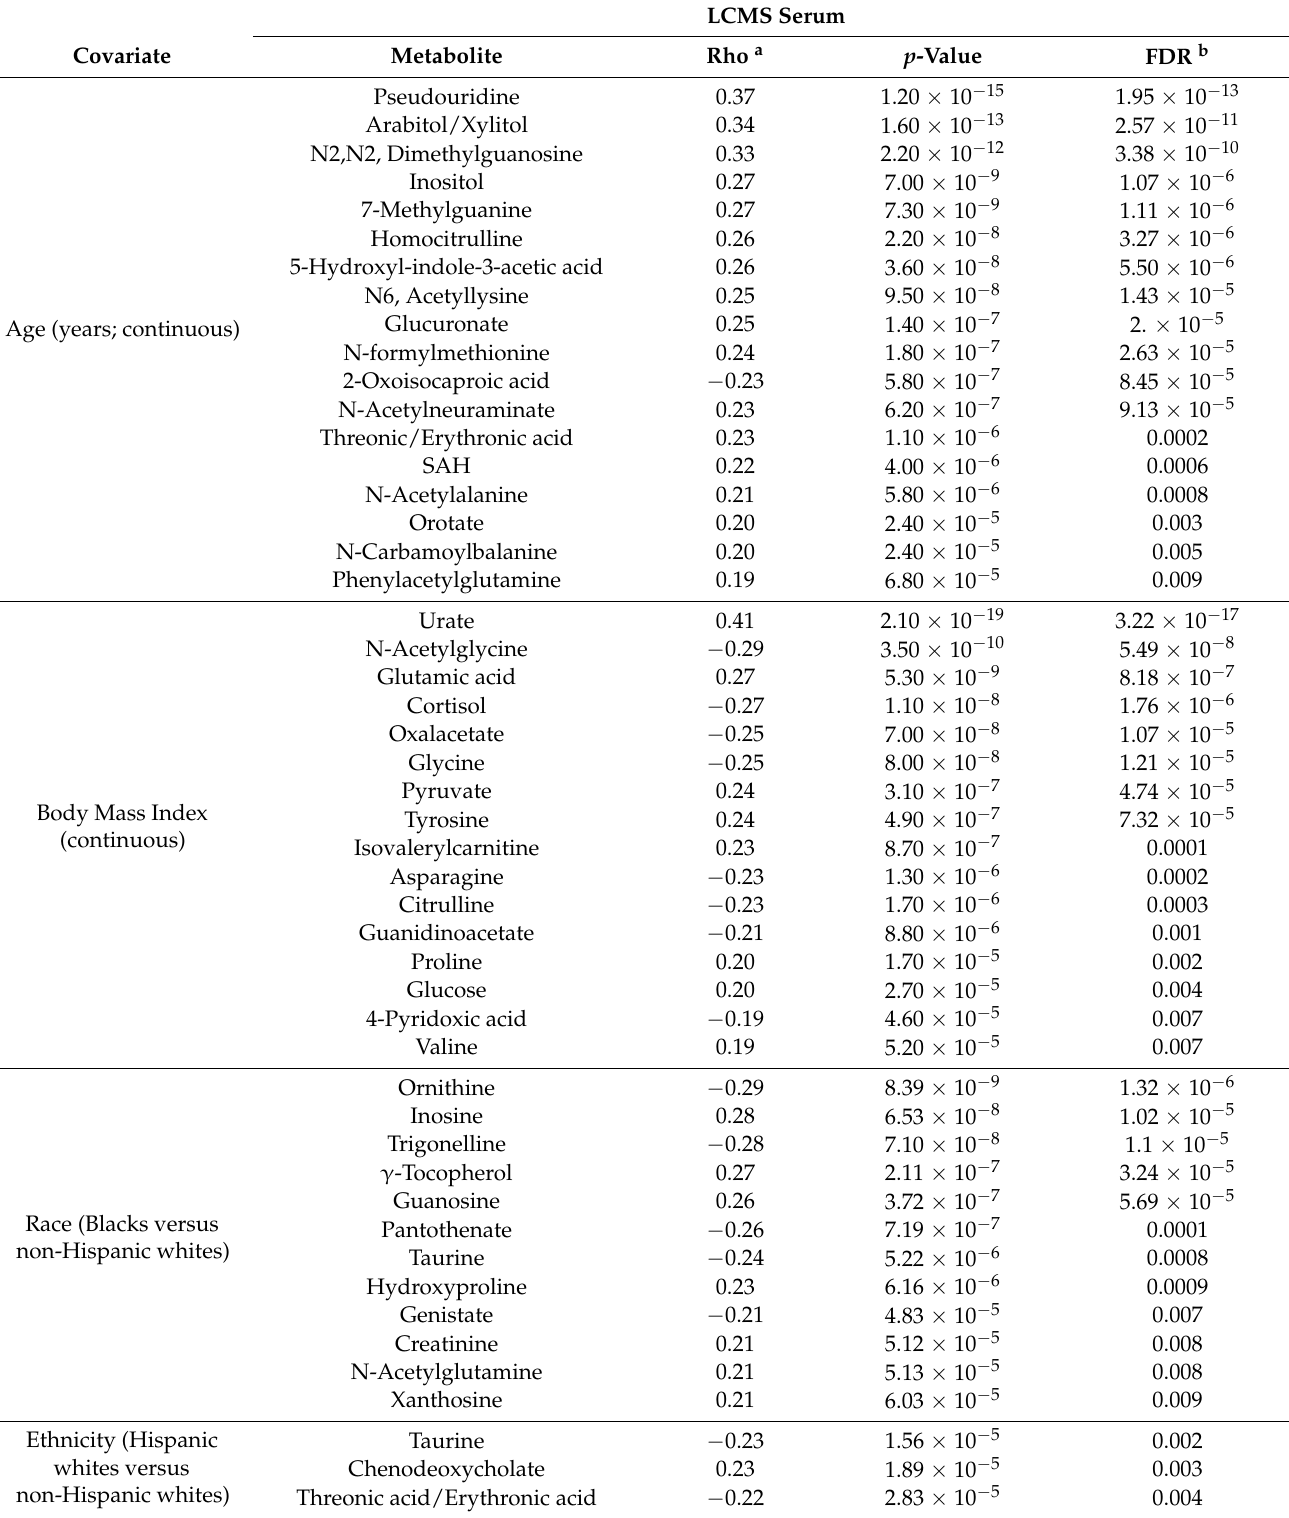
Table 2. Variables correlated with metabolites at FDR < 0.01 by LC-MS, descending in level of statistical significance within each